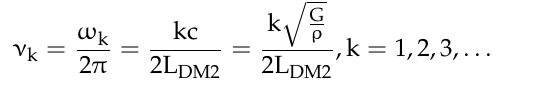
Table 3. Natural frequencies in torsion for DM2.